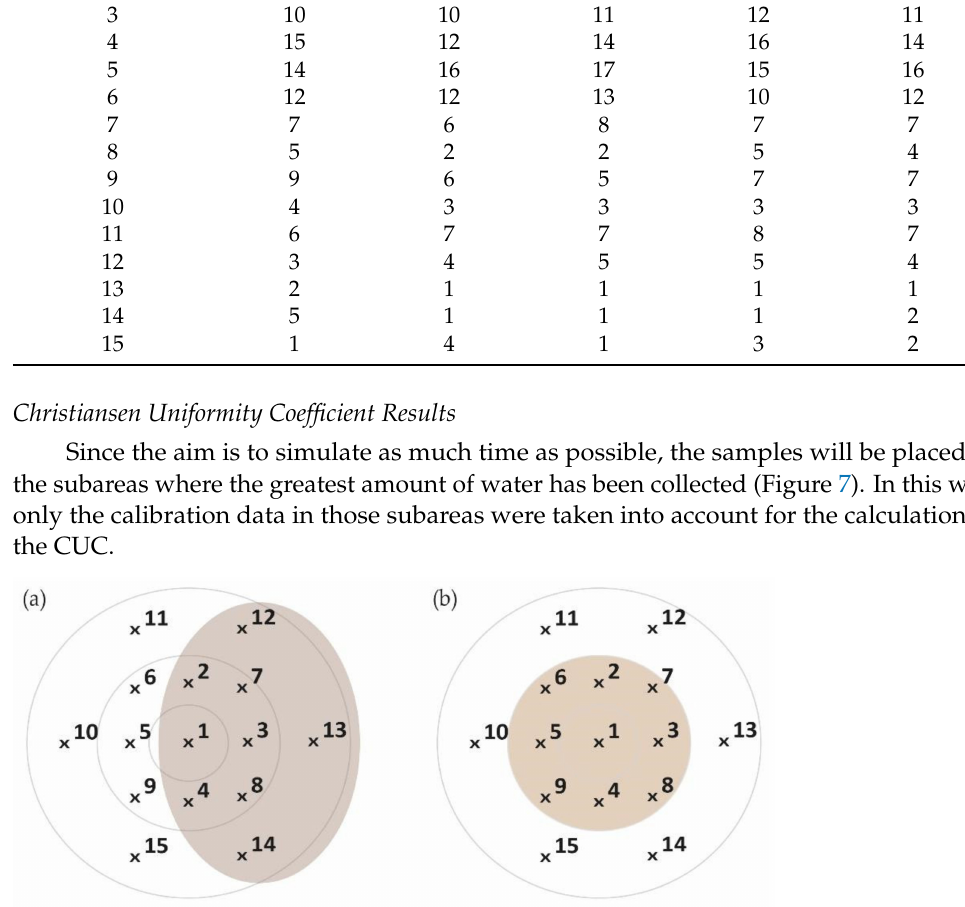
Figure 7. Subarea where the greatest amount of water was collected: ( a ) from wooden structure simulator and ( b ) from aluminum structure simulator.